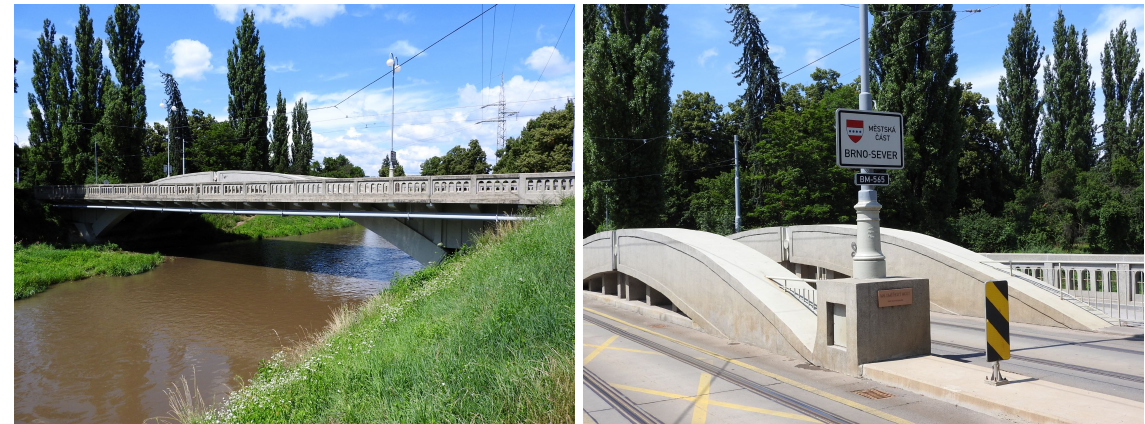
Figure 7. Three-hinge arch bridge at Brno – Husovice, 1928 (left – overall view, right – steel hinges).